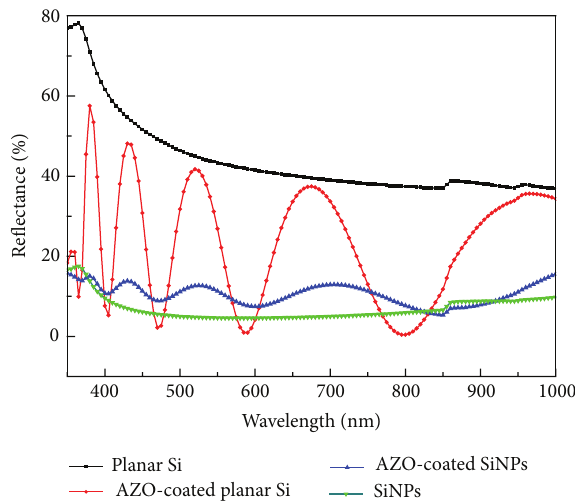
Figure 8: The reflectance profiles from planar Si, AZO-coated planar Si, SiNPs, and AZO-coated SiNPs. A comparative significant reduction of reflection was observed in AZO-coated SiNPs and nanopillar textured substrate